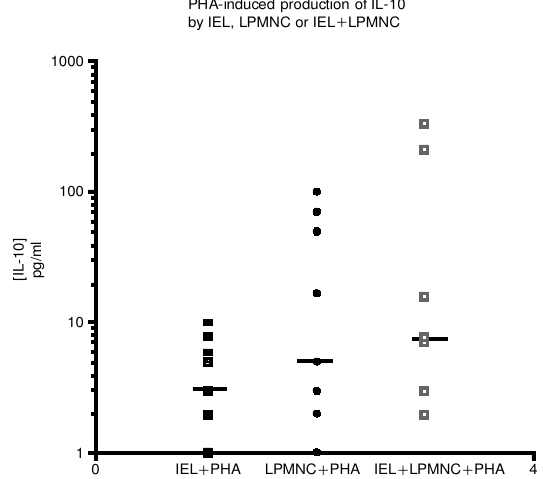
FIG. 1. Interleukin-10 concentration (pg ml) secreted by PHA-stimulated mucosal lymphocytes IL-10 production by LPMNC is minimally affected by the addition of IEL.